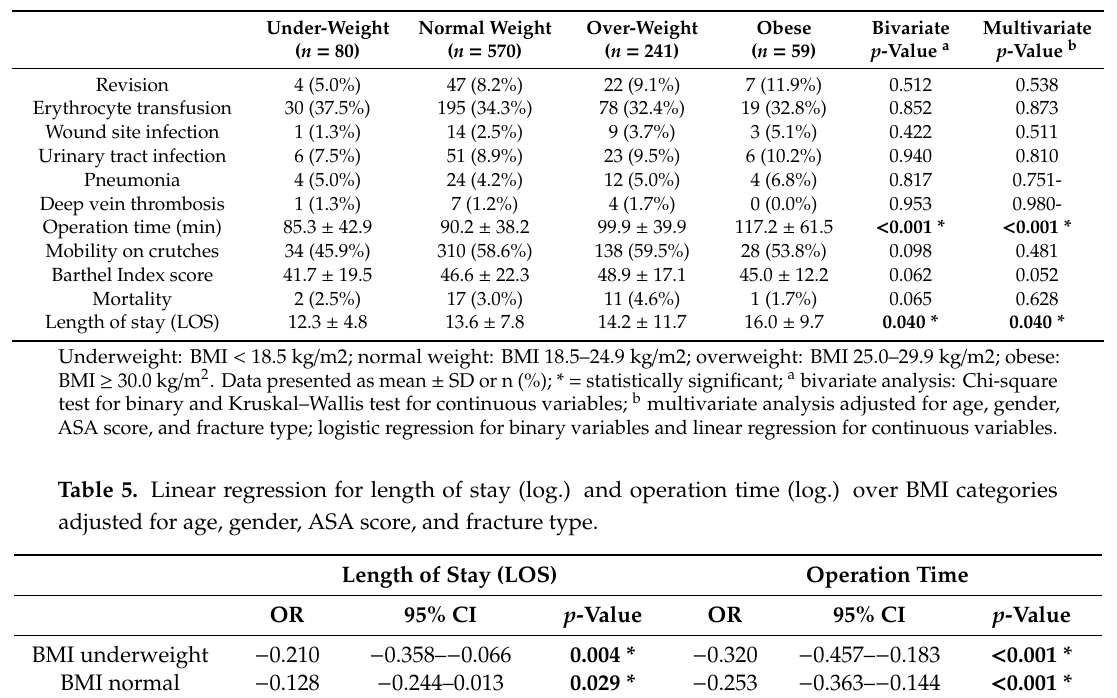
Table 4. Complications and outcome variables.